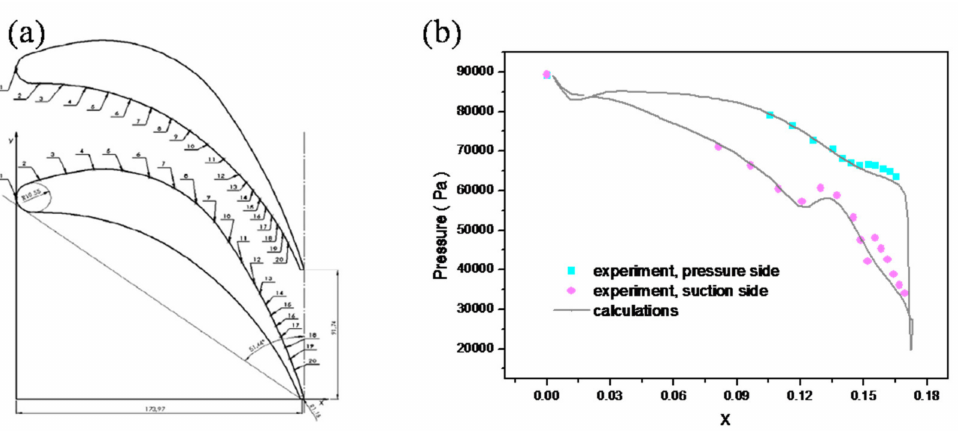
Figure 7. Validation: ( a ) schematic diagram of the blade and ( b ) static pressure distribution on the blade